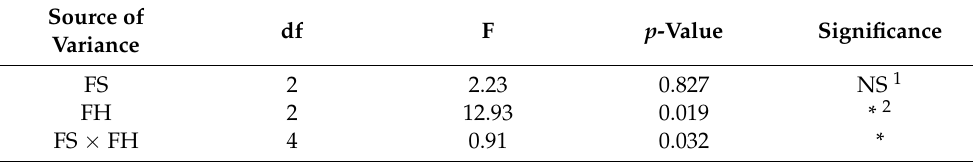
Table 7. Two-way analysis of variance for droplet deposition uniformity (DDUs). Source of